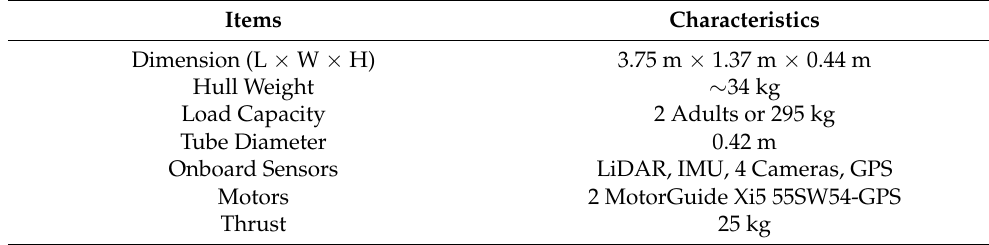
Table 1. Technical specification of the Åboat.